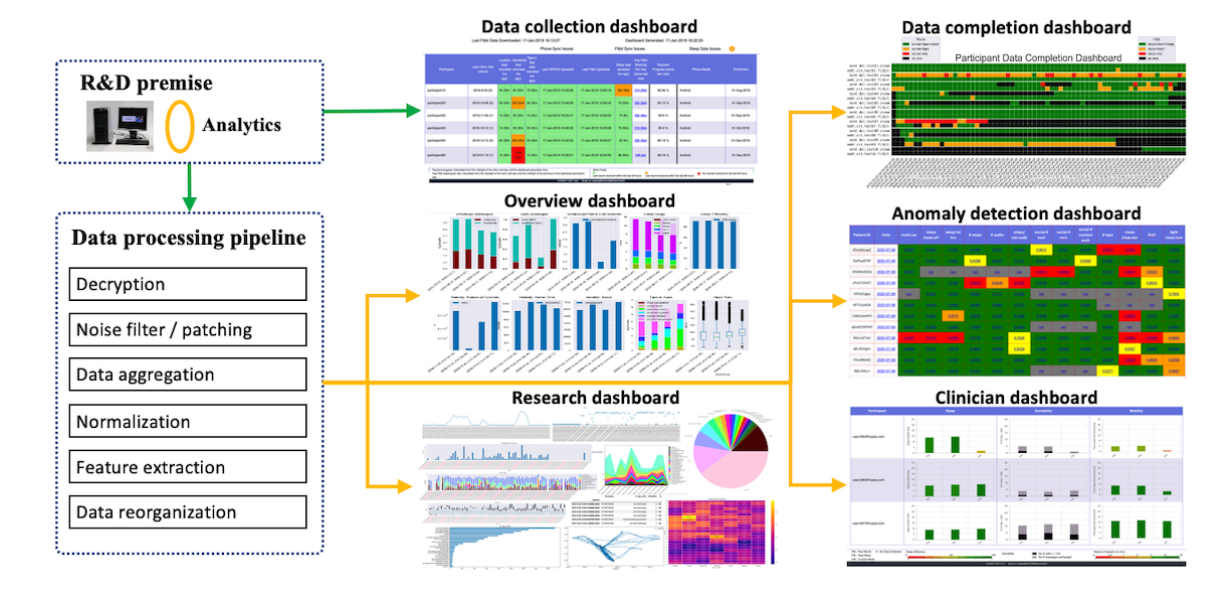
Figure 2. Backend data processing pipelines and